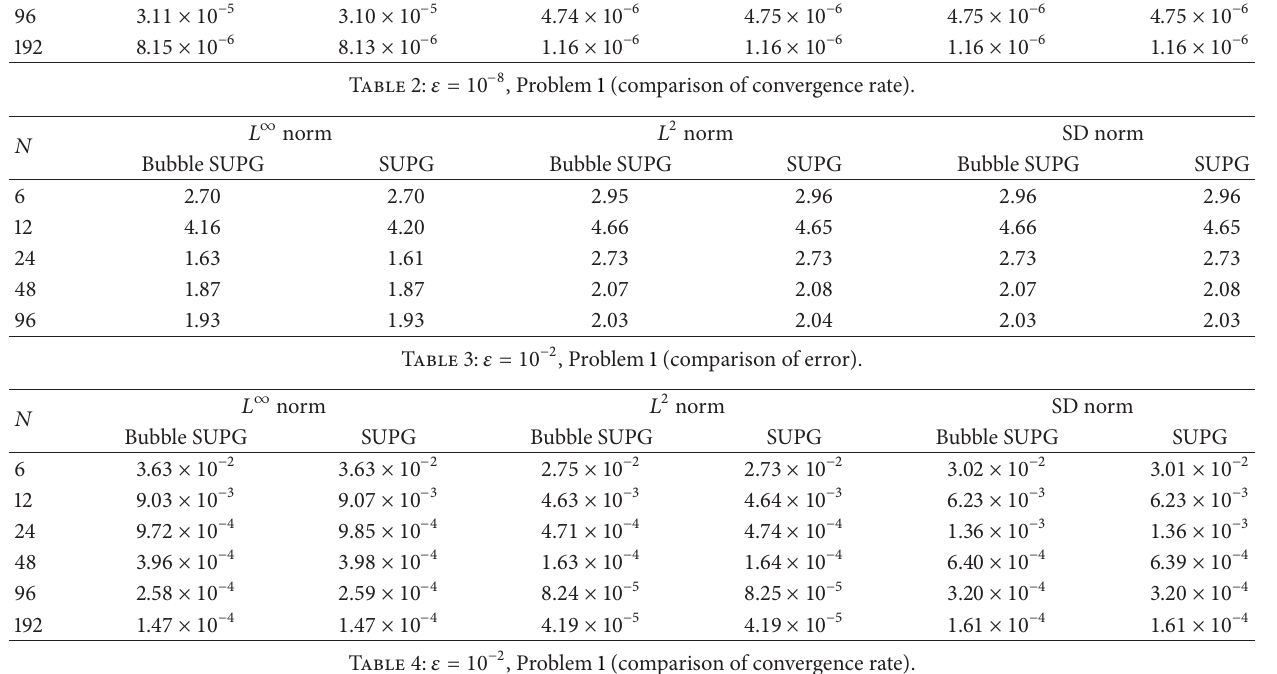
Table 4: 𝜀 = 10 −2 , Problem 1 (comparison of convergence rate).